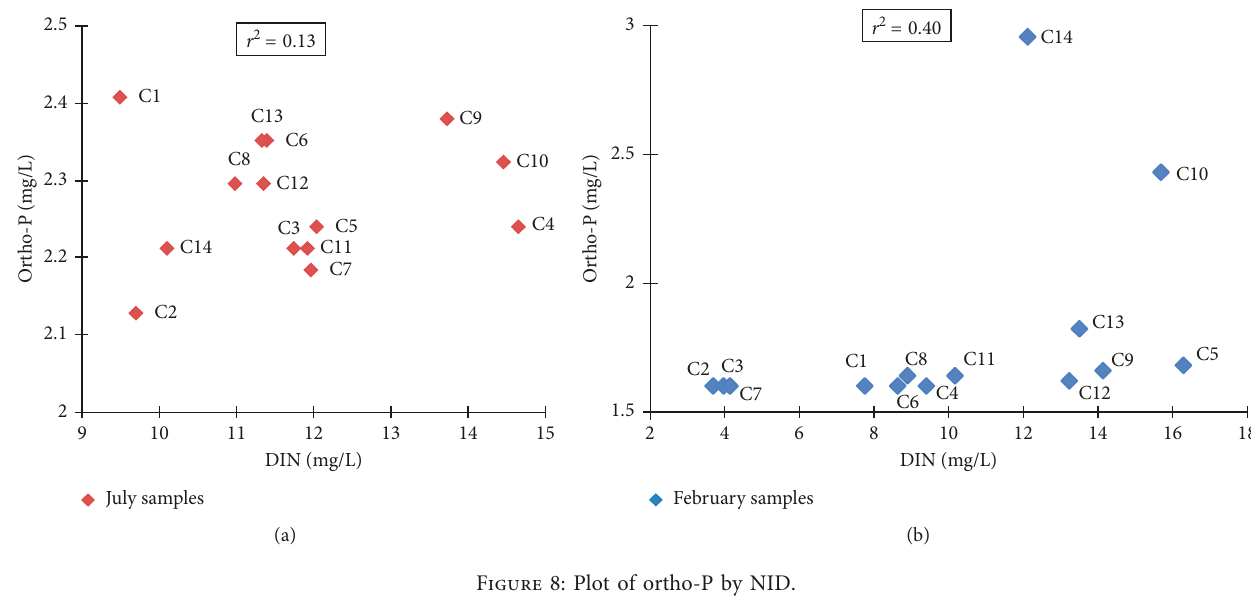
Figure 8: Plot of ortho-P by NID.